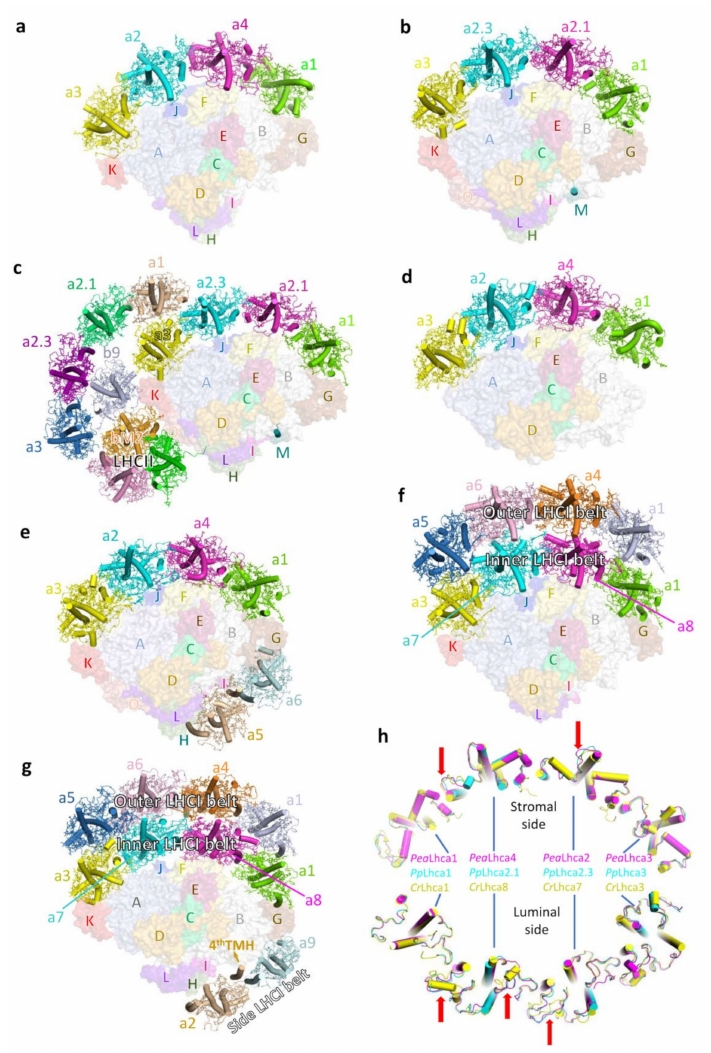
Figure 2. Overall structure of PSI–LHCI complexes from land plants and green algae. ( a ), Structure of the pea PSI–LHCI (PDB: 4Y28). ( b ), Structure of Pp PSI-S (PDB: 7KSQ). ( c ), Structure of Pp PSI-L (PDB: 8HTU). ( d ), Structure of D. salina PSI–LHCI with 4 Lhca proteins (PDB: 6RHZ). ( e ), Structure of D. salina PSI-LHCI with 6 Lhca proteins (PDB: 6SL5). ( f ), Structure of Cr PSI-LHCI with 8 Lhca proteins (PDB: 6JO6). ( g ), Structure of Cr PSI-LHCI with 10 Lhca proteins (PDB: 6IJO). The Lhca proteins are displayed as a cartoon, and their pigments, lipids and other co-factors are shown as sticks. The core subunits are displayed as a surface in different colors and labeled with a single letter (for example, the letter A represents PsaA). Pp PsaM in ( b , c ) is highlighted. ( h ), Comparison of the Lhca proteins in the (inner) LHCI belt from pea, P. patens and C. reinhardtii viewed from the stromal side and the luminal, side respectively. Lhca proteins from P. patens and C. reinhardtii were superposed separately on pea Lhca in their corresponding positions. Larger structural differences are highlighted by red